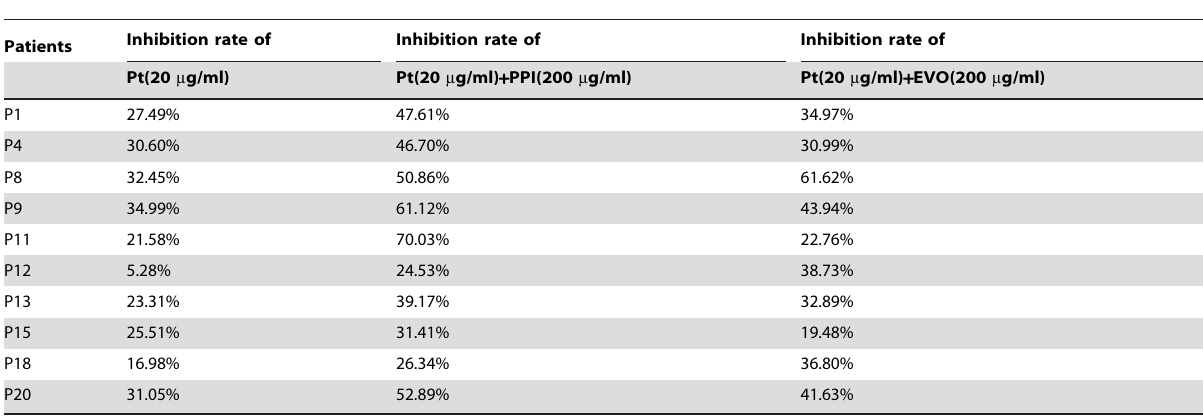
Table 2. The effects of PPI and EVO on reverse Pt resistance.